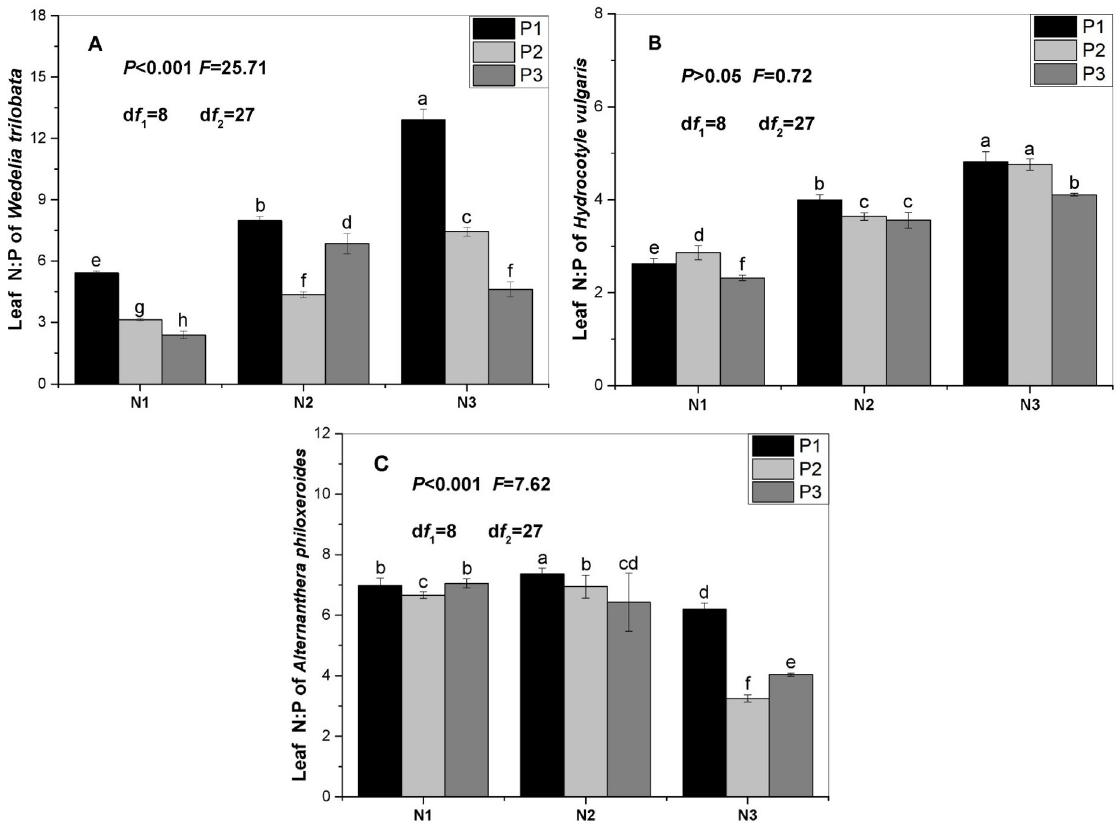
Fig 3. P ratio in leaf of the three alien plants subjected to different nutrient supplies. N: N1: Low nitrogen supply (1 mmol L -1 ); N2: Intermediate nitrogen supply (4 mmol L -1 ); N3: High nitrogen supply (8 mmol L -1 ); P1: Low phosphorus supply (0.15 mmol L -1 ); P2: Intermediate phosphorus supply (0.6 mmol L -1 ); P3: High phosphorus supply (1.2 mmol L -1 ). Values are means ± SE. Bars with different lowercase letters denote significant differences ( P < 0.05). https://doi.org/10.1371/journal.pone.0278656.g003 of phosphorus supply, a tendency of decreasing was observed in the nitrogen concentration of leaf when A . philoxeroides was subjected to nitrogen supply (N1 or N2). The possible explana- tion is that phosphorus addition incurred the use of internal nitrogen in issue or organ of plant [18]. As the same time, the tendency of decreasing first and then increasing was observed in the nitrogen concentration of leaf when A . philoxeroides was subjected to nitrogen supply (N3). The possible explanation is that efficiency and proficiency of N resorption significantly